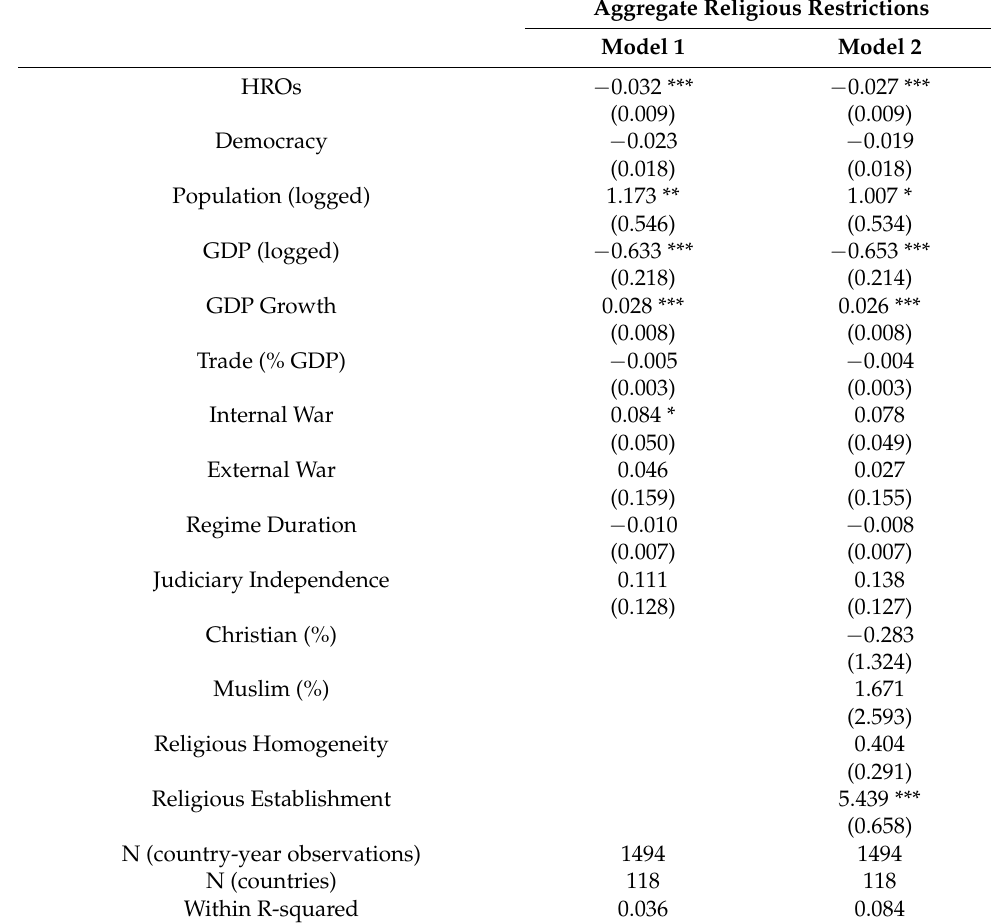
Table 3. The Effect of Domestic Presence of HROs on Aggregate Religious